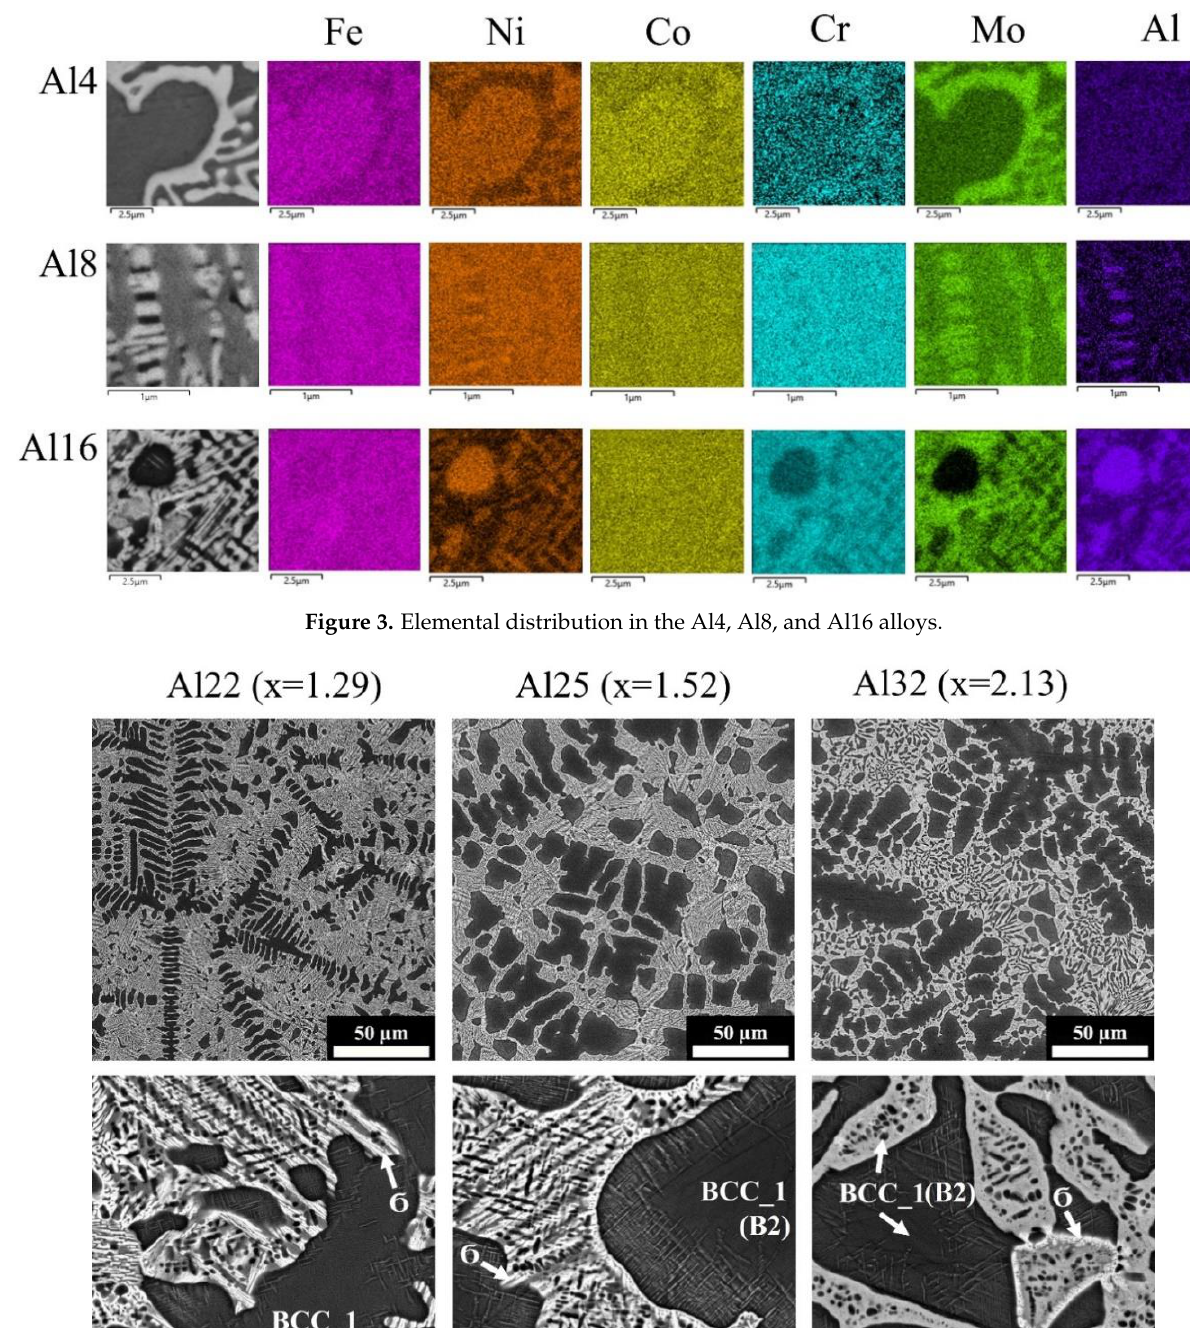
Figure 5. Elemental distribution in the Al22, Al25, and Al32 alloys.